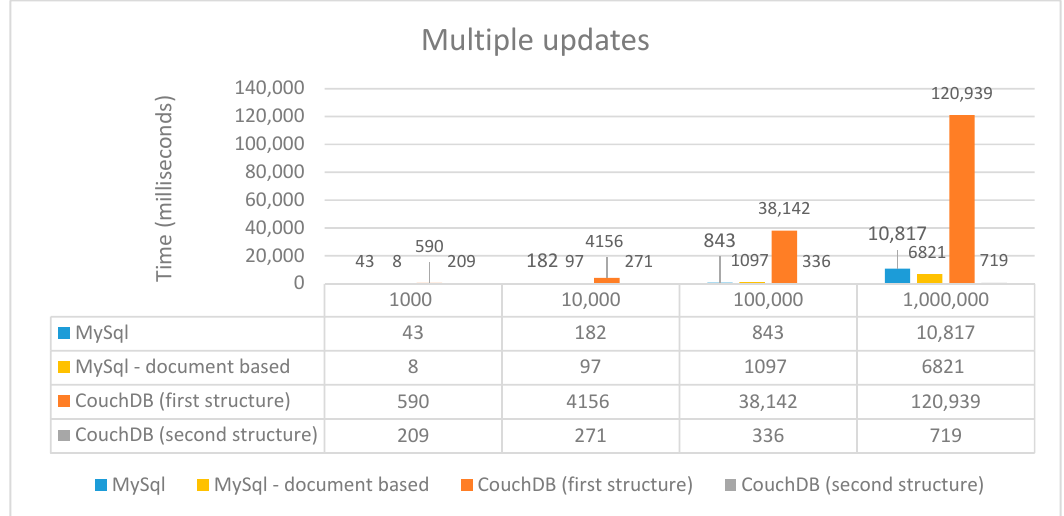
Figure 6. Performance time (ms) for the multiple update operation.